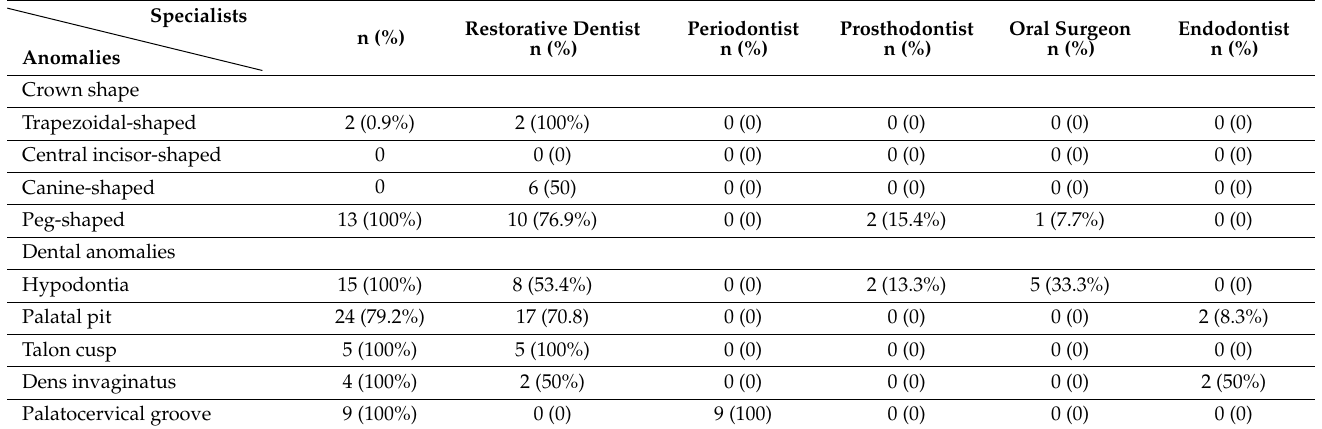
Table 3. The distribution of additional specialists included in subjects’ treatment according to crown shapes and affiliated anomalies.